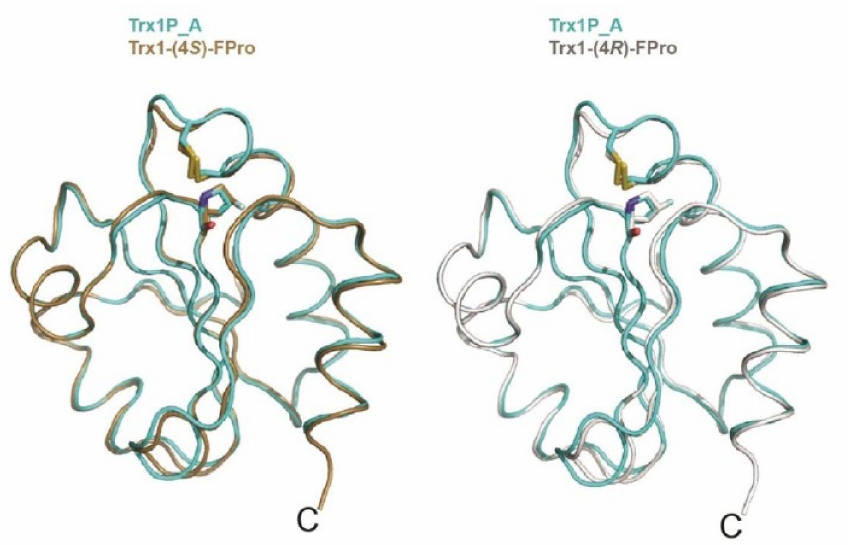
Figure 3. Overlay of chain A of Trx1P (cyan) on oxidized chain A of Trx1P-(4R)-FPro (light gray), on the right, and chain A of Trx1P-(4S)-FPro (brown), on the left. The cis-Pro76, cis-(4R)-FPro and cis-(4S)-FPro residues and the side chains of Cys32 and Cys35 forming the catalytic disulfide bond are shown in sticks, adapted from Ref.